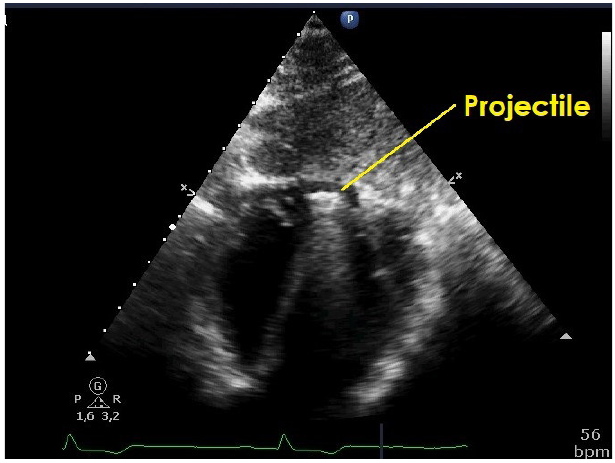
Fig. 1 - Echocardiogram showing the projectile inside the right ventricle.